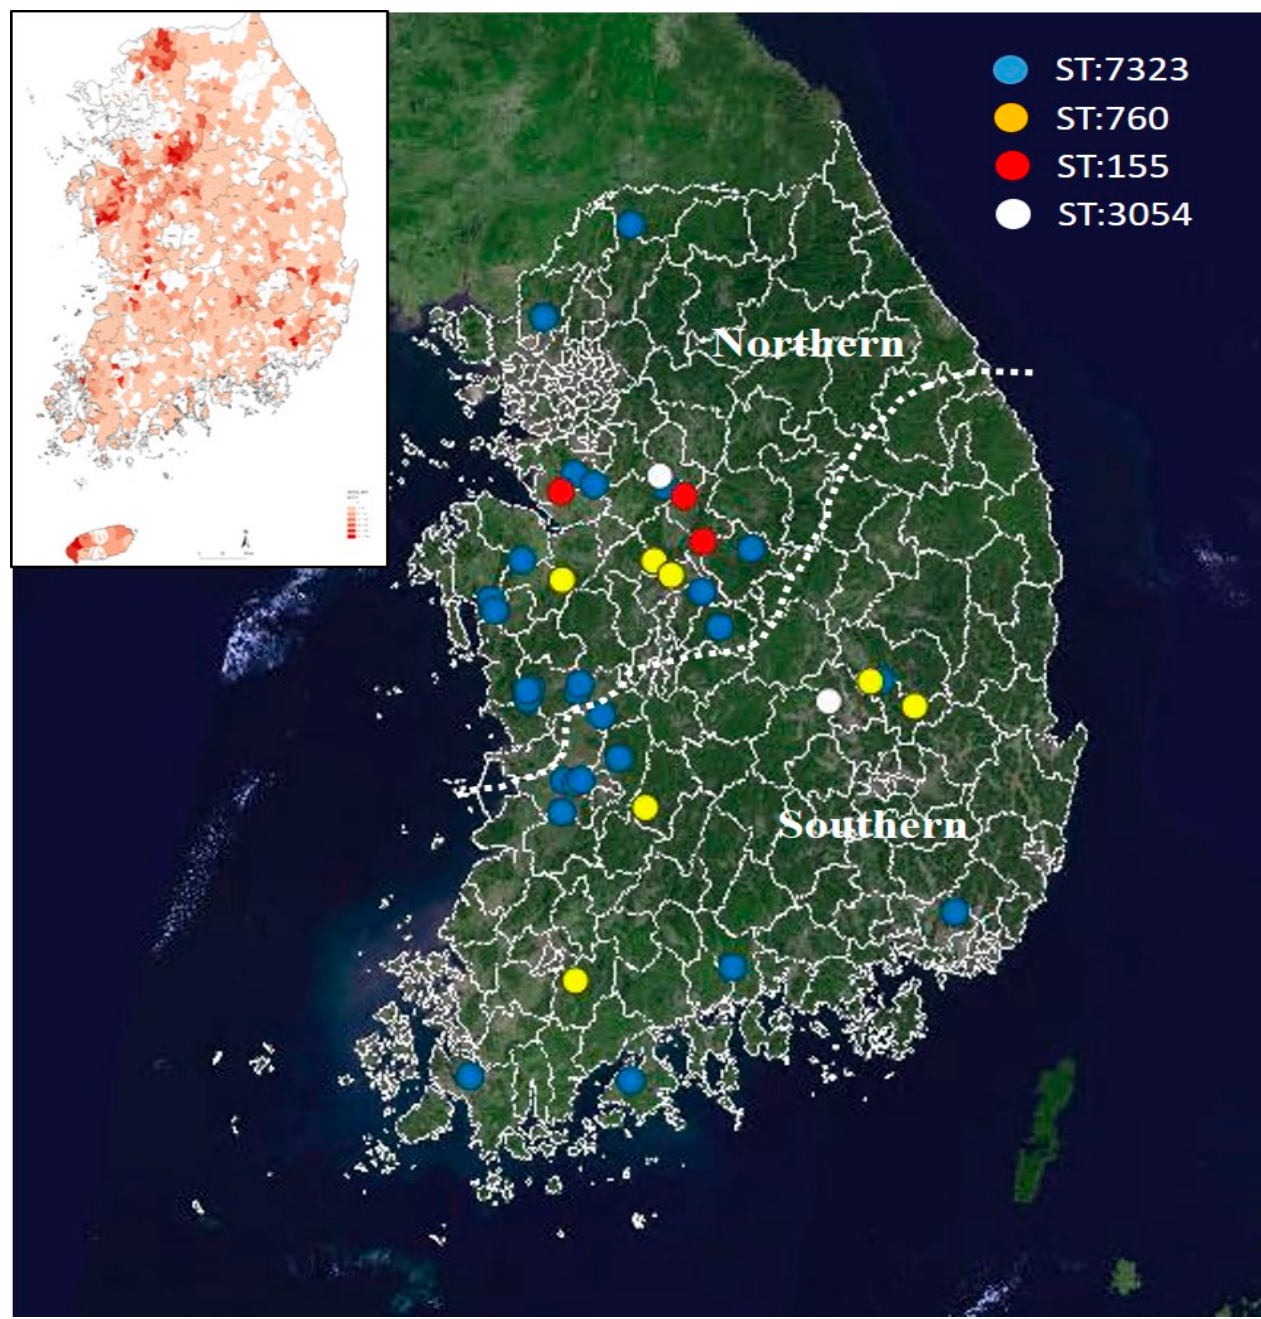
Figure 5. Regional distribution of F18:STa:STb virotype sequence type (ST7323, ST760, ST155, and ST3054) on the map. The density of all pig farms in South Korea.